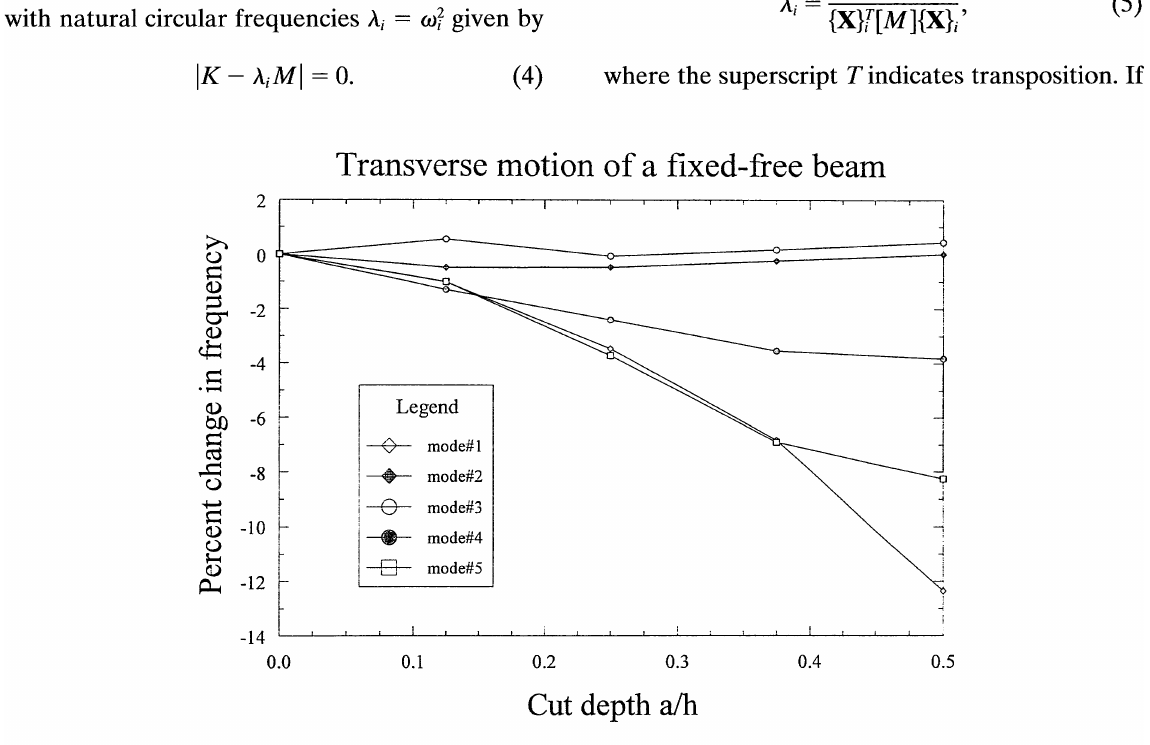
FIGURE 3 Comparison of mode number in frequency sensitivity with increasing